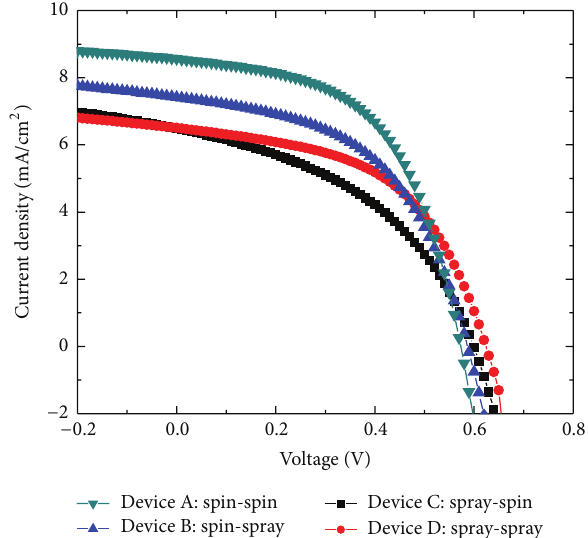
Figure 6: 𝐽 - 𝑉 characteristics of the OPVs fabricated by different combinations of electrospray deposition and spin